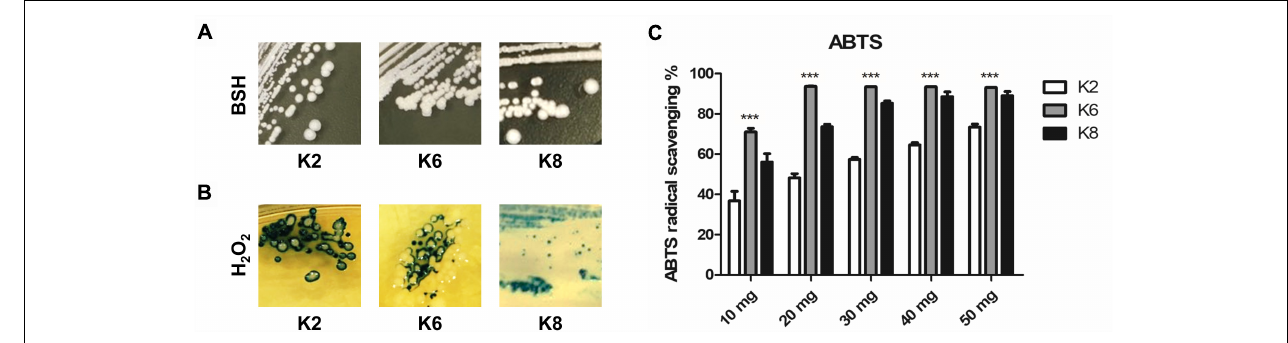
FIGURE 2 | Functional properties of L. plantarum ATG-K2, ATG-K6, and ATG-K8 showing (A) bile salt hydrolase activity, (B) hydrogen peroxide production, and (C) ABTS radical scavenging activities of lysates of each strain. Statistical significance ∗∗∗ of (C) indicates p < 0.001 when K6 compared to K2 and K8.